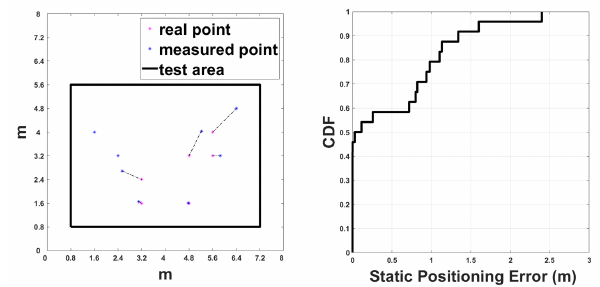
Figure 10. Static positioning and the CDF of error.